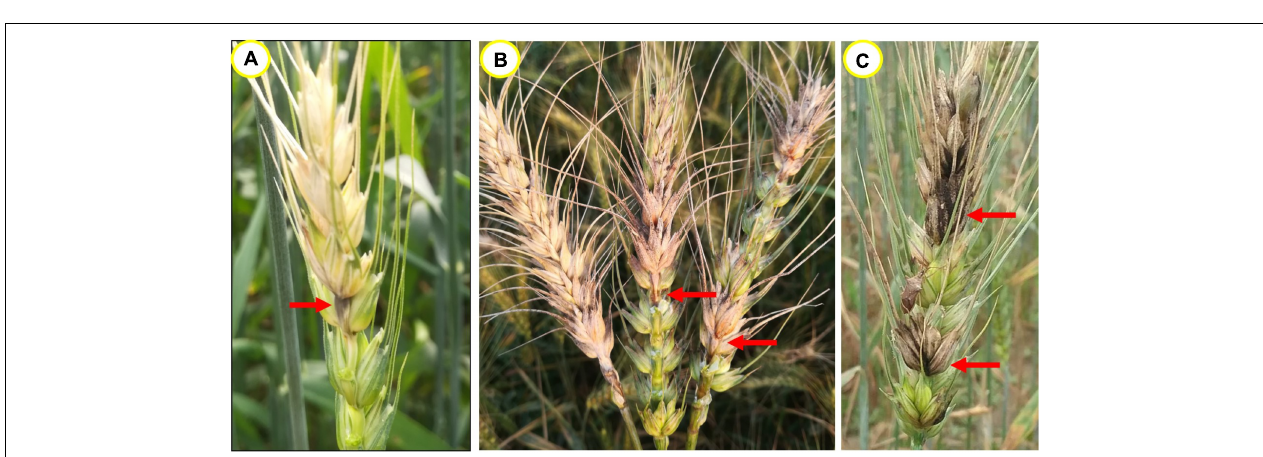
FIGURE 2 | Blast and blast-like symptoms on wheat heads. (A) A typical blasted head having gray colored infection point, (B) symptoms of FHB showing superficial pink to orange masses of spores of F. graminearum with pink colored infection points, and (C) symptoms of spot blotch giving black discoloration on the infected spikelets because of B. sorokiniana